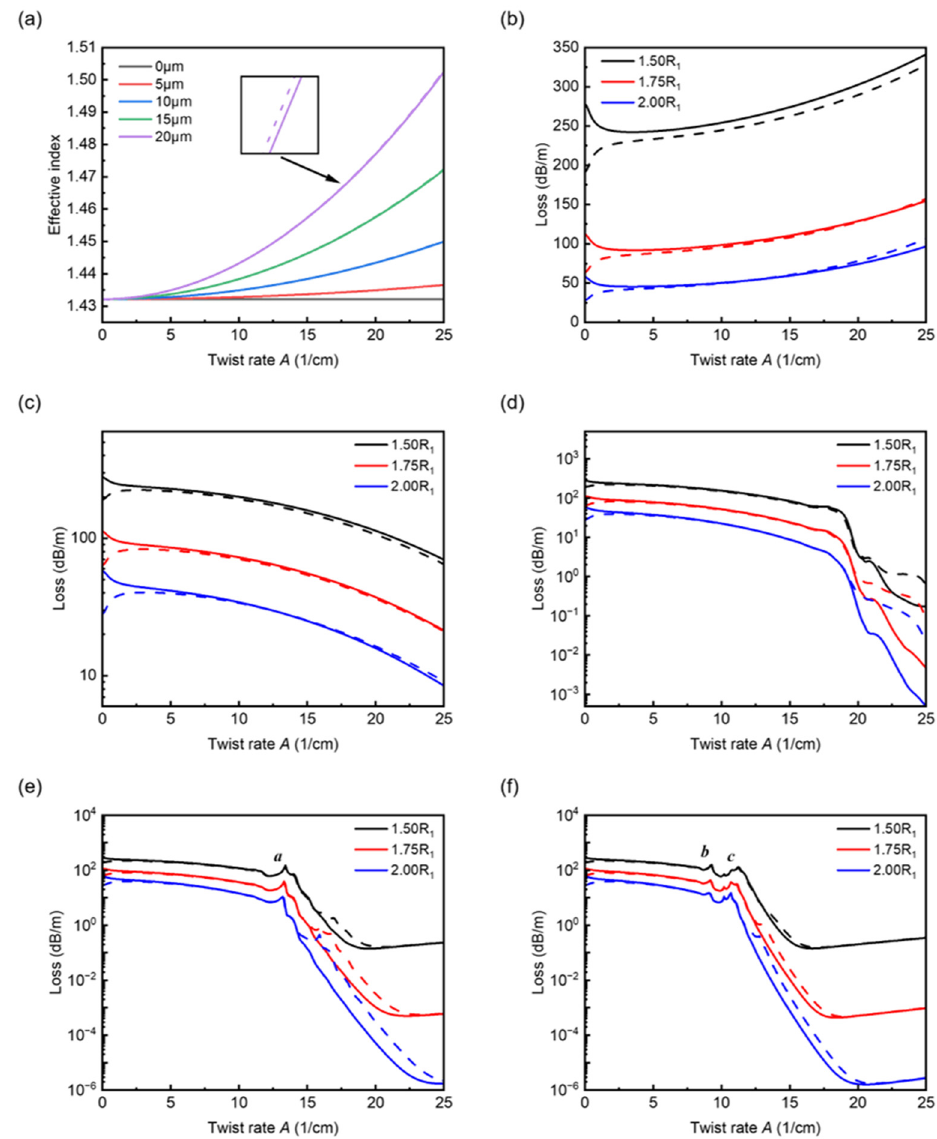
Figure 2. Effective indices and loss spectra of the HE − (solid lines) and HE + (dash lines) fundamental modes for five core offsets. ( a ) Effective indices versus twist rate with R 2 = 1.5R 1 . ( b – f ) Loss spectra for core offsets ρ = 0, 5, 10, 15 and 20 μ m with R 2 /R 1 varying from 1.5 to 2.0.